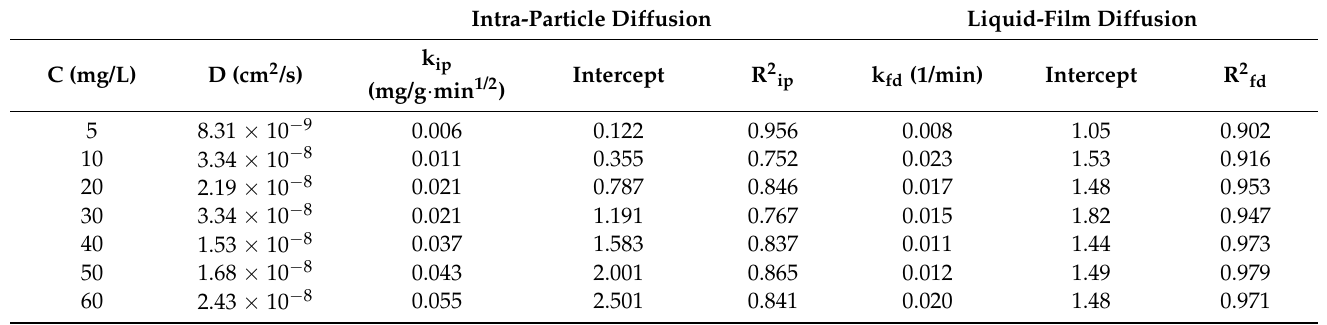
Table 4. Calculated parameters of intra-particle and liquid-film diffusion models for RR dye adsorp- tion onto yeast surface (C i = 5–60 mg/L, 1.5 g biomass, 700 rpm, pH = 6.0 ± 0.2, T = 20 ± 2 ◦ C).